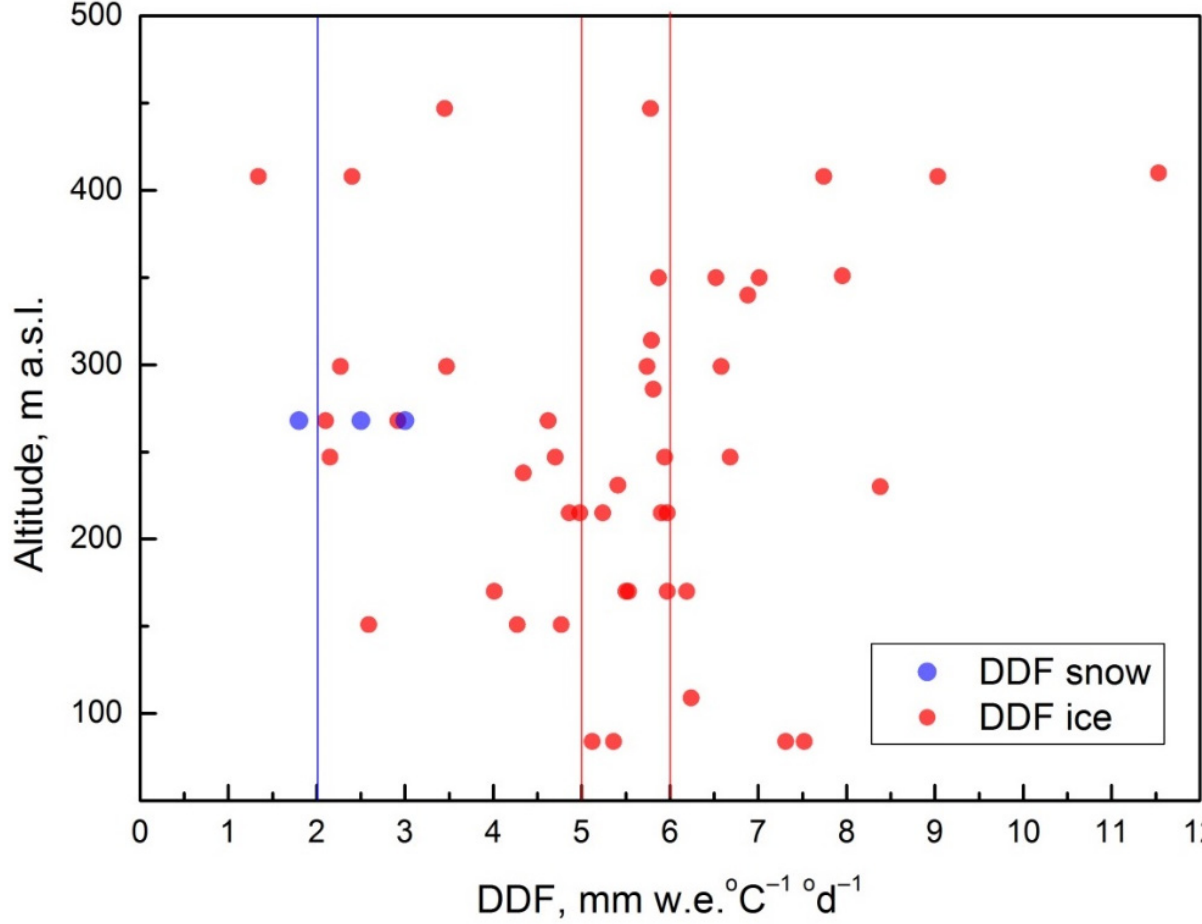
Figure 4. The variety of observed DDFs for snow and ice measured from the stakes. Blue and red lines show the DDFs for snow and ice that were used after the model was calibrated.